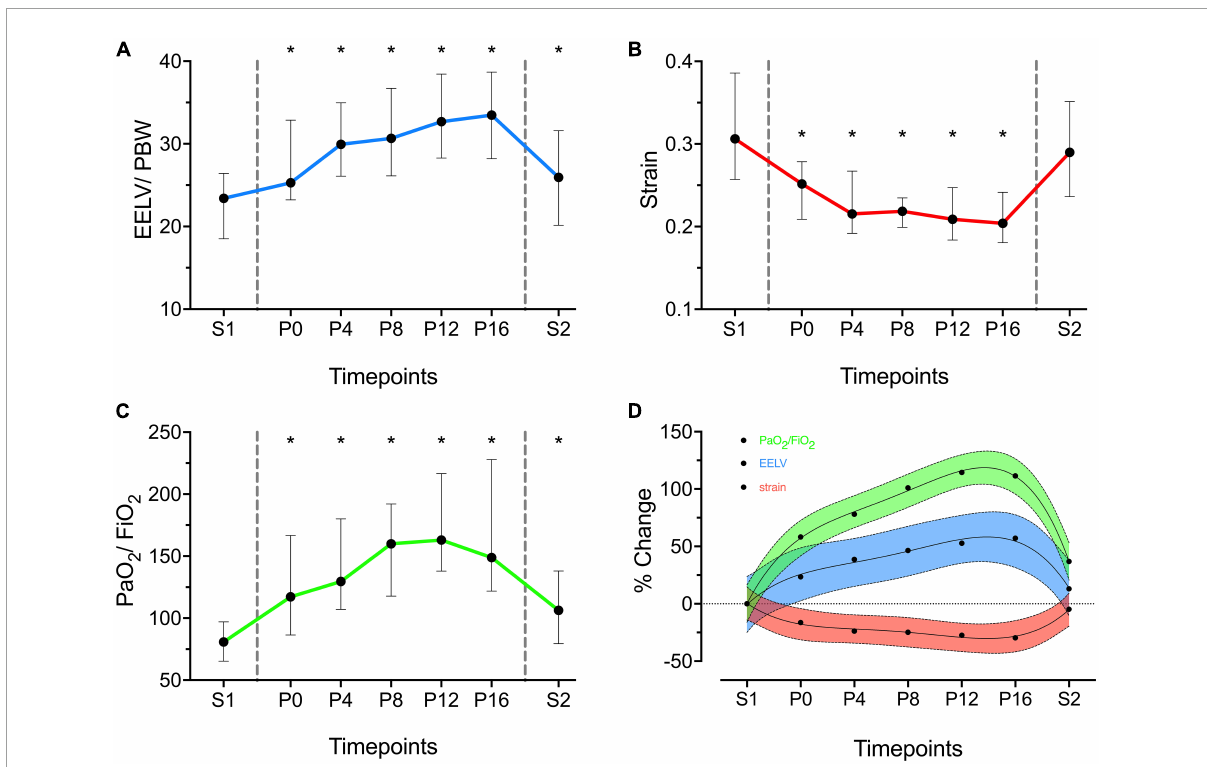
FIGURE1 End-expiratory lung volume/predicted body weight (EELV/PBW – ml/kg) (A) , Strain (B) and PaO 2 /FiO 2 (C) over time. X axis represents timepoints. Y axis represents absolute values of the variables. Data are presented as median and Inter Quartile Range. Areas within vertical dashed lines indicate prone position. *Statistically significant versus S1. (D) Cumulative percentage Increase in EELV/PBW (blue), Strain (red) and PaO 2 /FiO 2 (green) as compared to S1 (S1 = 0%). Data are presented as mean and connecting regression line. Color shaded area indicates 95% Prediction Band of the regression